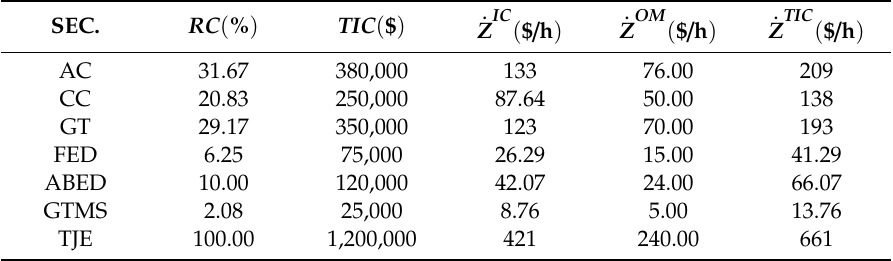
Table 4. The equations respecting exergy and cost balance of the TJE.